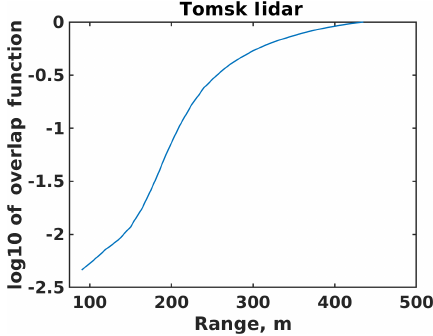
Figure 2. Geometrical overlap function used for the correction of the lidar data in log10 scale between 100 and